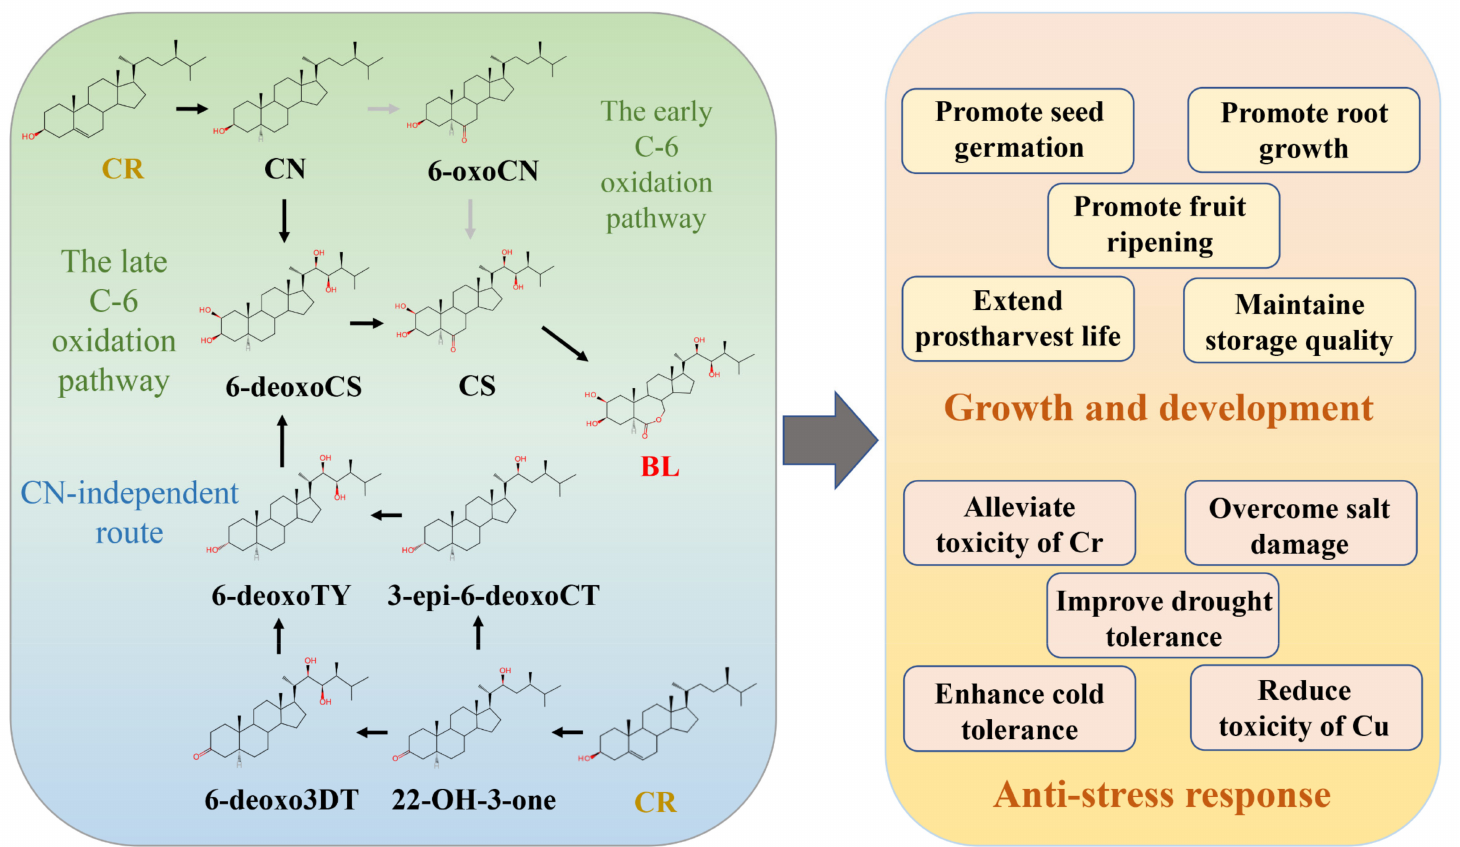
Figure 1. The biosynthetic pathway and roles of brassinosteroids (BRs) in the growth, development, and stress response of plants. The campestanol (CN)-dependent pathway: In the early C-6 oxidation pathway, CN is converted to 6-oxocampestanol (6-oxoCN), and 6-oxoCN is then converted to castasterone (CS). Additionally, in the late C-6 oxidation pathway, CN is converted to 6-deoxocastasterone (6-deoxoCS), which is converted to CS. The CN-independent pathway: 22-hydroxycampest-3-one (22-OH-3-one) is converted to 6-deoxo-3- dehydroteasterone (6-ddeoxo3DT) and 3-epi-6-deoxocastasterone (3-epi-6-deoxoCT) on different branches, and they are converted to 6-deoxotyphasterol (6-deoxoTY). The final synthesis product of different pathways is BL. BRs regulate plant growth and development by promoting seed germination, root growth, and fruit ripening, extending postharvest, and maintaining storage quality. Additionally, BRs are able to respond to different types of stress: alleviating the toxicity of Cr, overcoming salt damage, improving drought tolerance, enhancing cold tolerance, and reducing the toxicity of